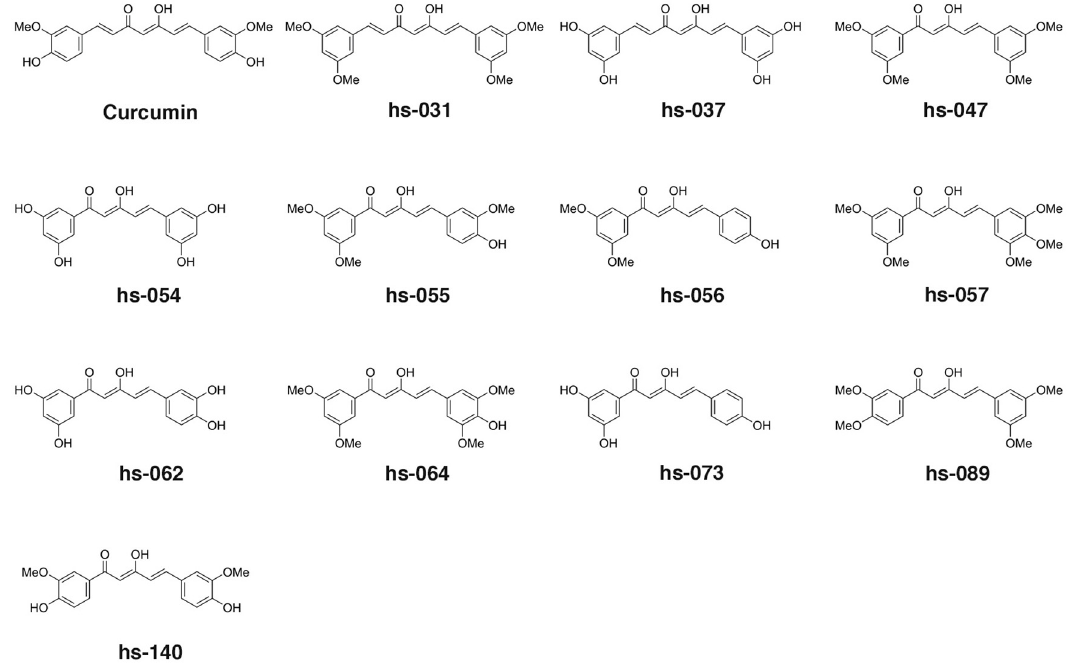
Figure 1. Chemical structure of curcumin and curcumin derivatives used in this study.